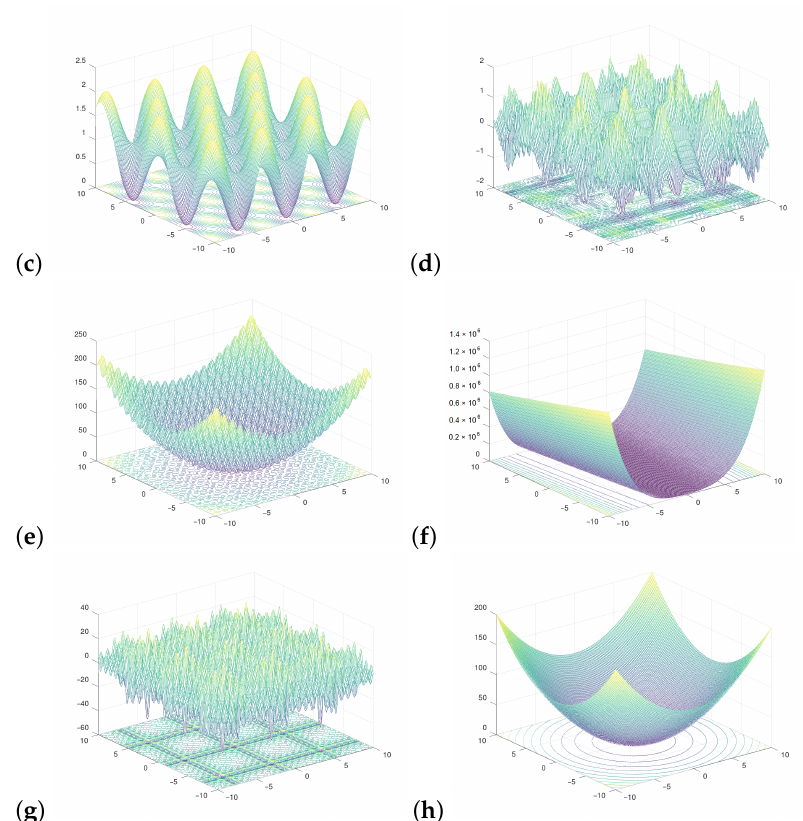
Figure 2. Selected fitness functions used to test the proposed algorithms: ( a ) Ackley, ( b ) Easom, ( c ) Griewank, ( d ) Michalewitz, ( e ) Rastrigin, ( f ) Rosenbrock, ( g ) Schubert, and ( h ) Sphere.